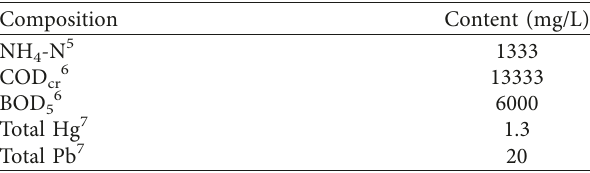
Figure 3: Schematic diagram for the artificial leachate permeation test. Table 5: Compositions of artificial leachate.